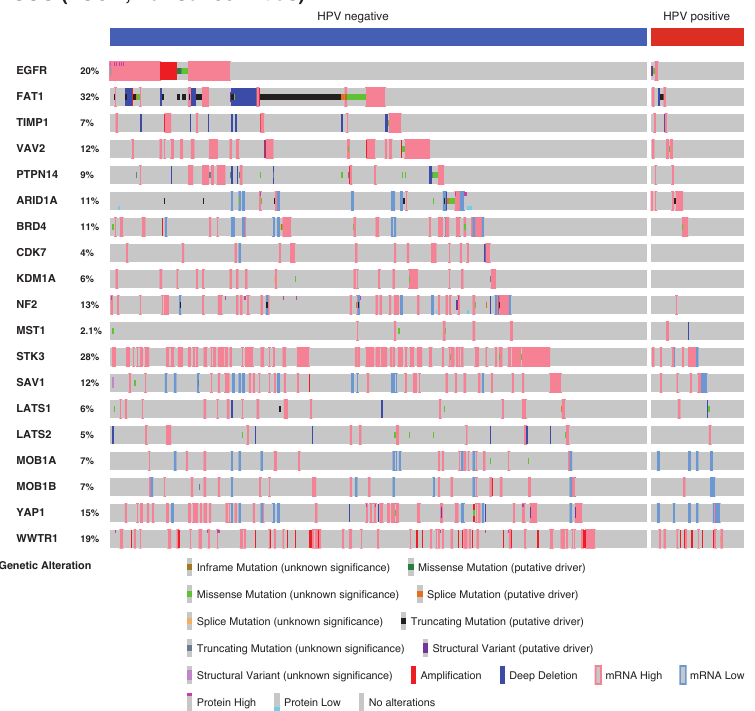
Figure 2. Landscape of the genetic alterations dysregulating the Hippo pathway and YAP/TAZ in HNSCC. The landscape was created by c-BioPortal for Cancer Genomics (https://www.cbioportal.org accessed on 19 September 2022) by analyzing the data of the HNSCC TCGA, PanCancer Atlas (2015). Abbreviations are: Epidermal growth factor receptor (EGFR), FAT atypical cadherin 1 (FAT1), tissue inhibitor of metalloproteinase-1 (TIMP-1), vav guanine nucleotide exchange factor 2 (VAV2), protein tyrosine phosphatase non-receptor type 14 (PTPN14), AT-rich interaction domain 1A (ARID1A), bromodomain containing protein 4 (BRD4), Cyclin dependent kinase 7 (CDK7), and Lysine-specific demethylase 1